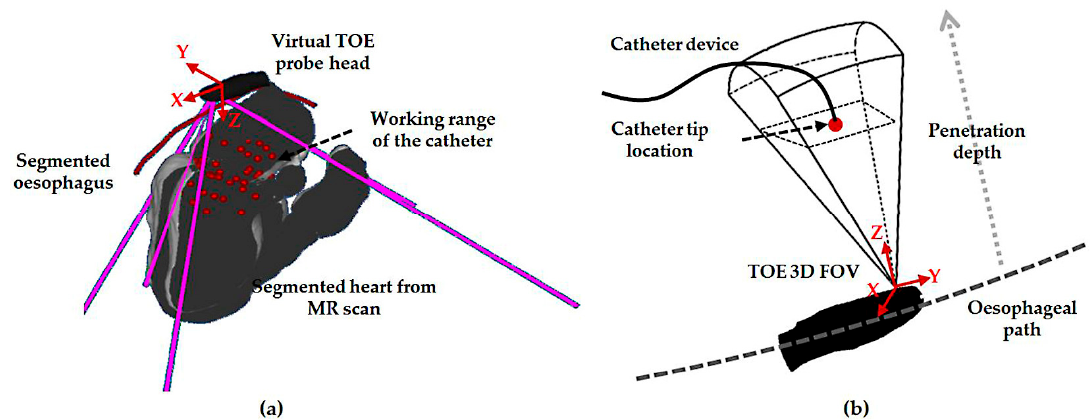
Figure 2. ( a ) Illustration of the initialization step using the view-planning platform to automatically decide the probe location in the approximately correct region; ( b ) Illustration of the localized probe